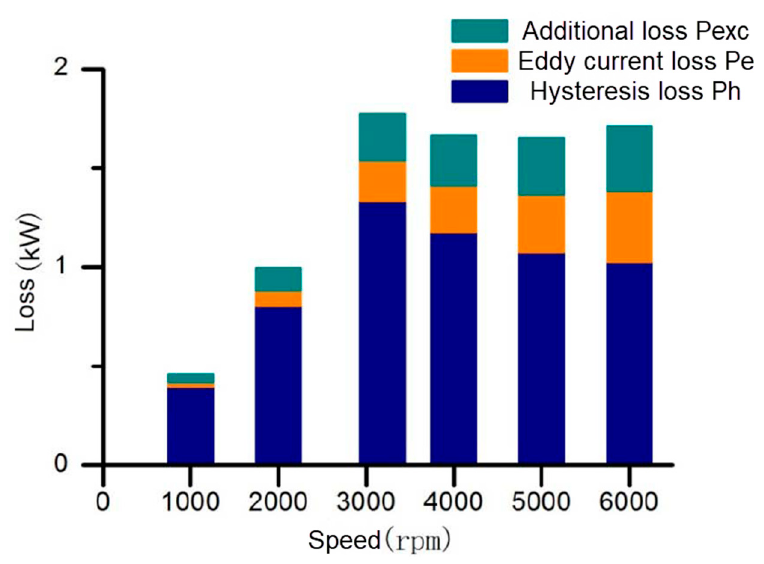
Figure 12. Decomposed core loss under different speed loads.